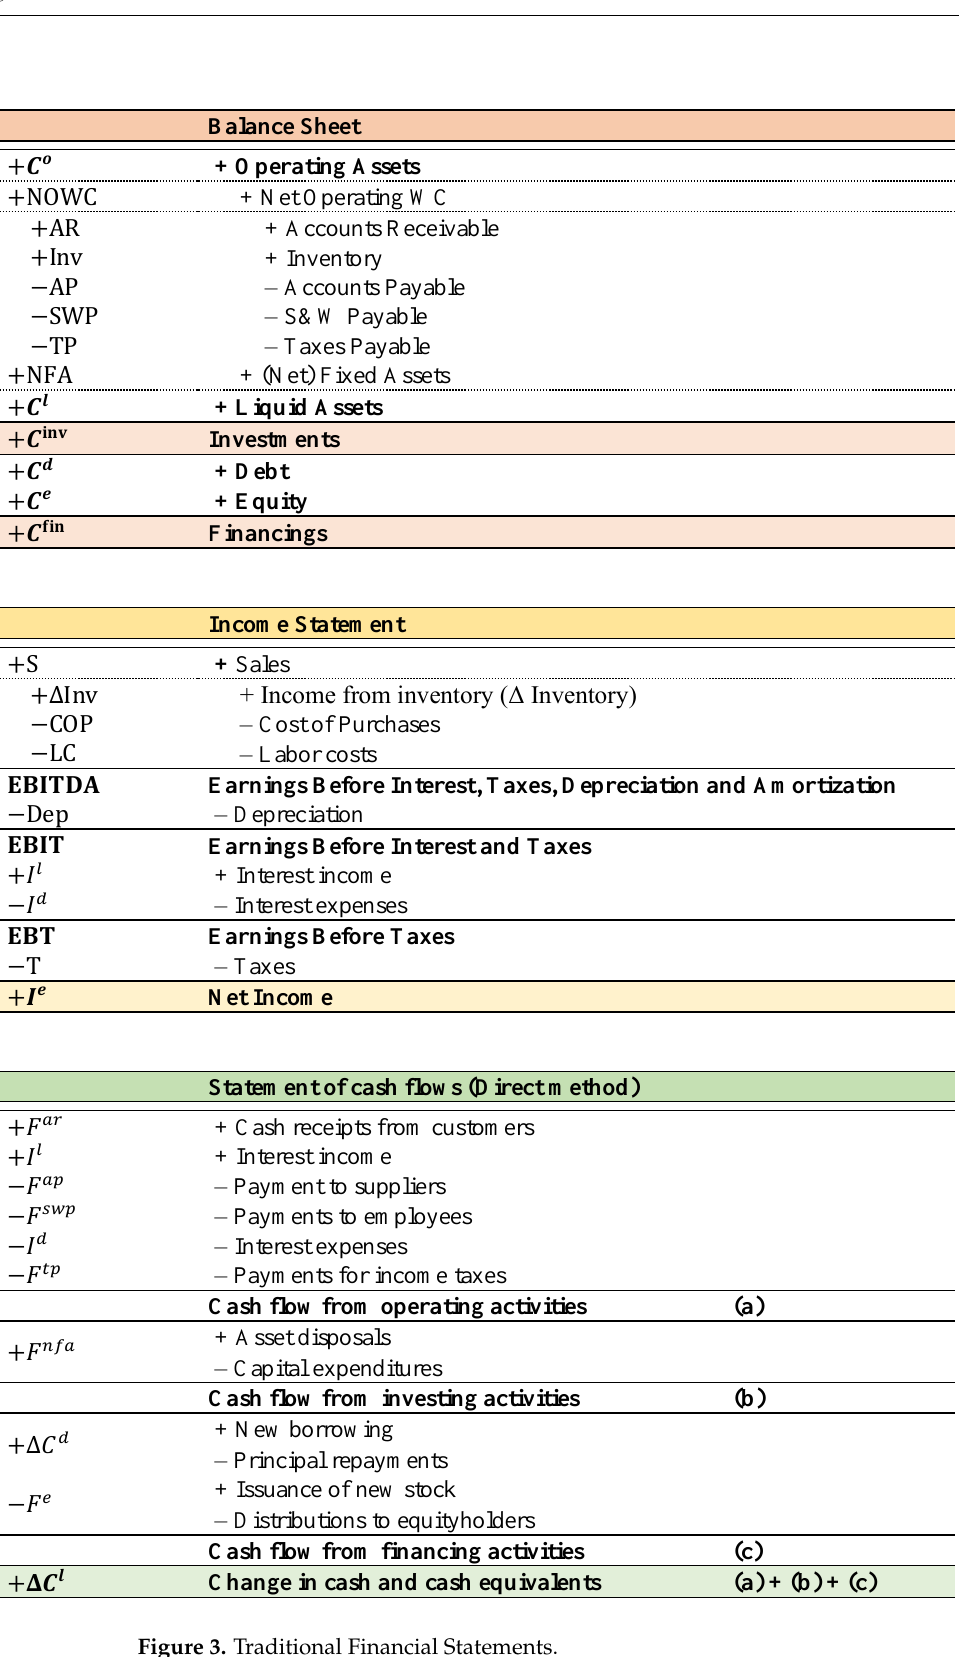
Figure 3. Traditional Financial